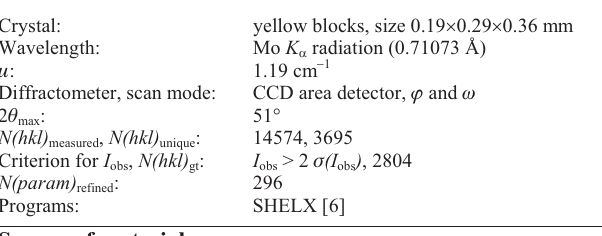
Table 1. Data collection and handling.